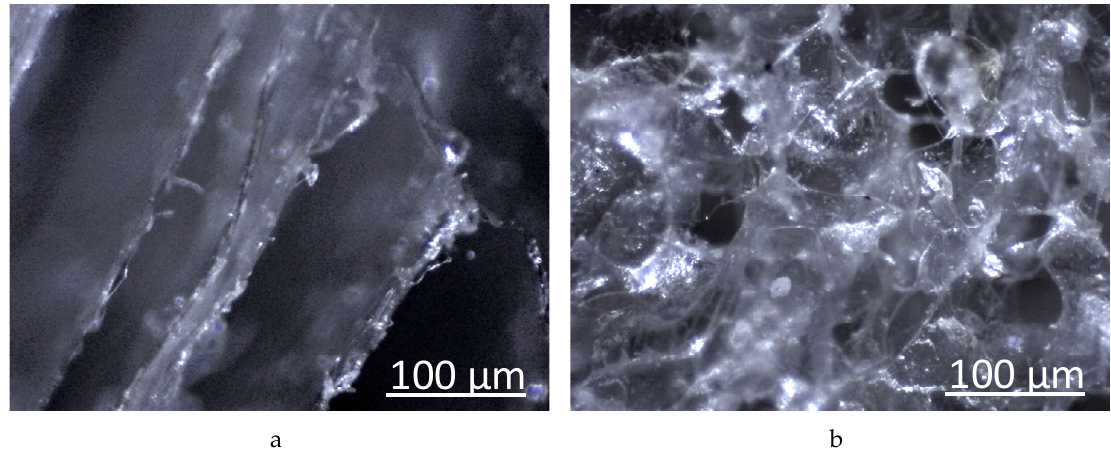
Figure 2. X-ray diffraction patterns: 1—CNW; 2—lyophilized ALG-CNW microgel, isolated from the ALG-CNW (7.5%) hydrogel; 3—lyophilized ALG hydrogel; 4—lyophilized ALG-CNW (7.5%).